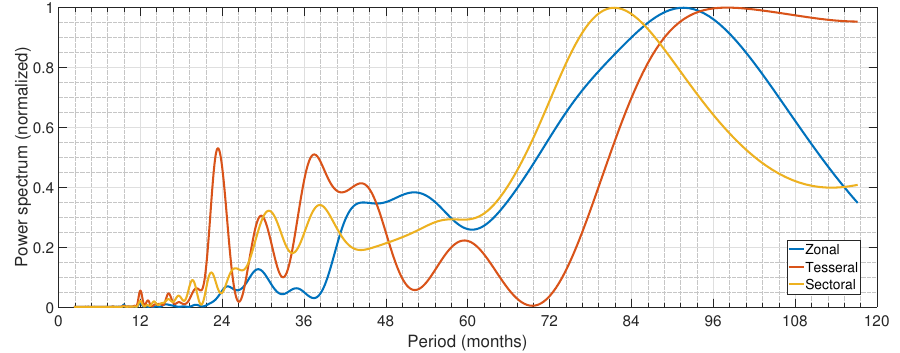
Figure 1. Multivariate spectral analysis of the second derivative of zonal, tesseral, and sectoral spherical harmonics coefficients up to degree